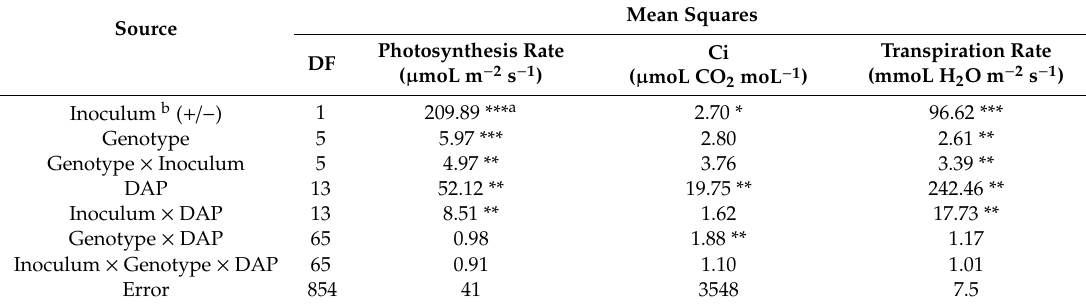
Table 2. Analysis of variance for photosynthesis rate, intercellular carbon dioxide concentration (Ci), and transpiration rate.